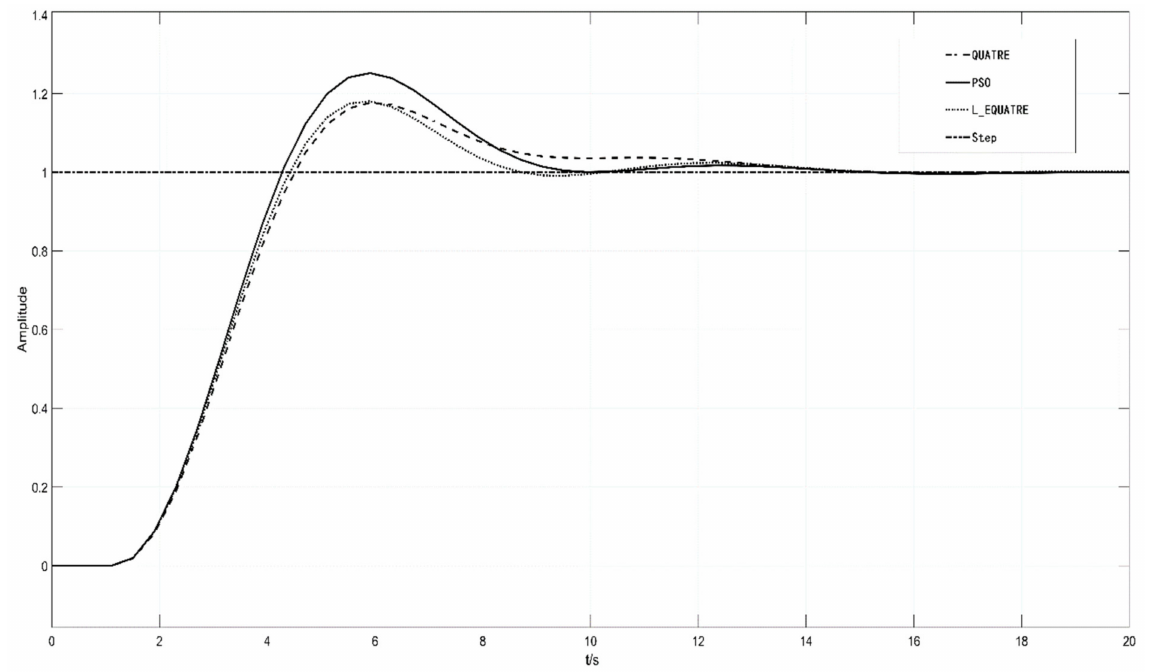
Figure 8. The unit response curve of the third-order controlled